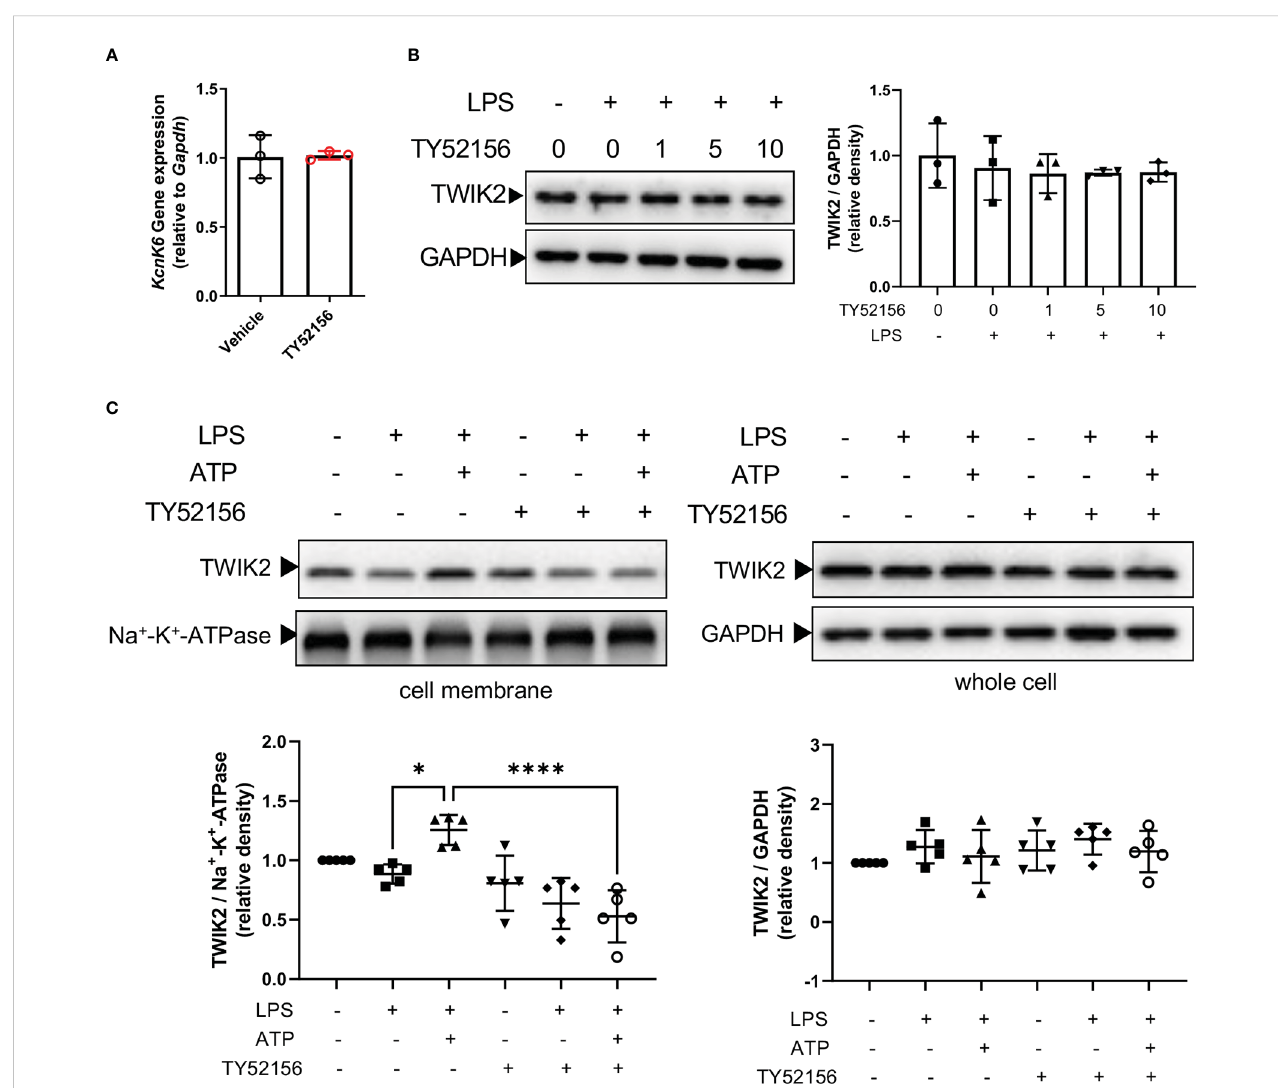
FIGURE 5 Inhibition of S1PR3 suppresses ATP-induced potassium ef fl ux through TWIK2 membrane traf fi cking. (A) BMDMs were primed with LPS (1 m g/mL) and treated with TY52156 (10 m M) or vehicle for 4h. The mRNA expression of KcnK6, which codes TWIK2, was measured by RT-qPCR (n=3). Values are presented as mean ± SD. Data were analyzed with a two-tailed t-test. (B) BMDMs were primed with LPS (1 m g/mL) and treated with TY52156 (0, 1, 5, 10 m M) for 4h. The TWIK2 in BMDMs was measured by Western blot (n= 3). Values are presented as mean ± SD. Data were analyzed with one-way ANOVA. (C) BMDMs were primed with LPS (1 m g/mL) and treated with TY52156 (10 m M) or vehicle, followed by ATP (3mM) stimulation for 30 min. The TWIK2 in the plasma membrane and whole-cell were measured by Western bot (n= 5). Values are presented as mean ± SD. *p < 0.05, ****p < 0.0001, one-way